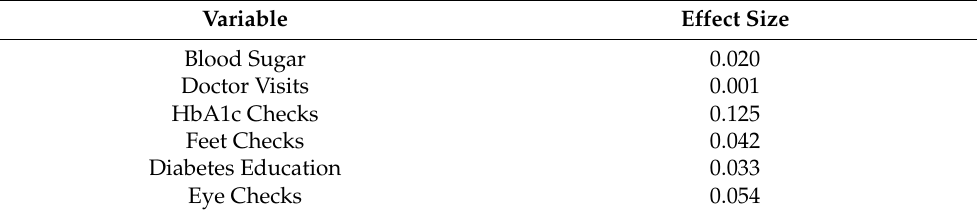
Table 3. Pseudo-R 2